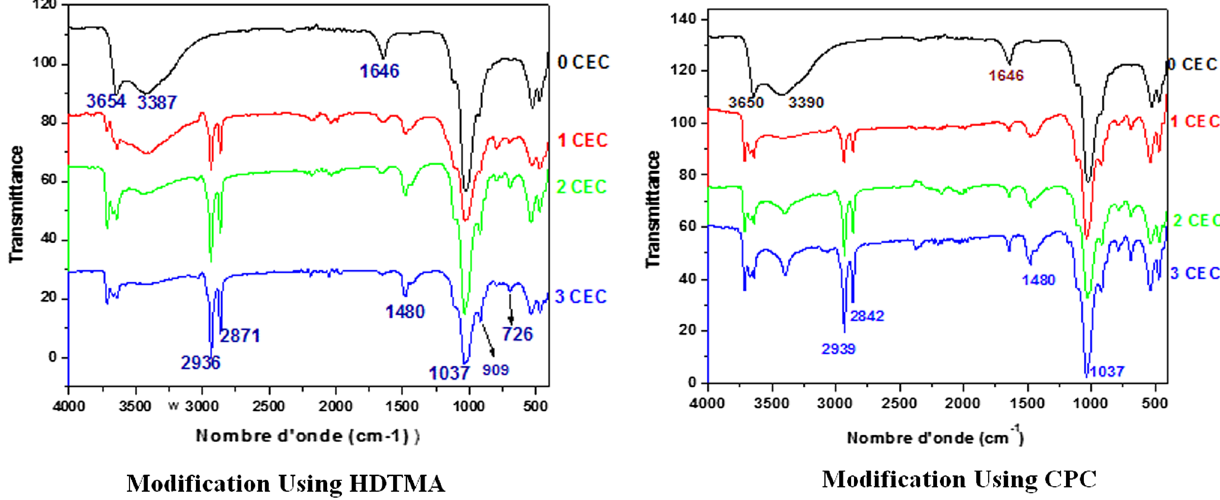
Fig. 3 FTIR spectra of purified clay (0 CEC) and organophilic clays by HDTMA and CPC (different concentrations 1, 2 and 3